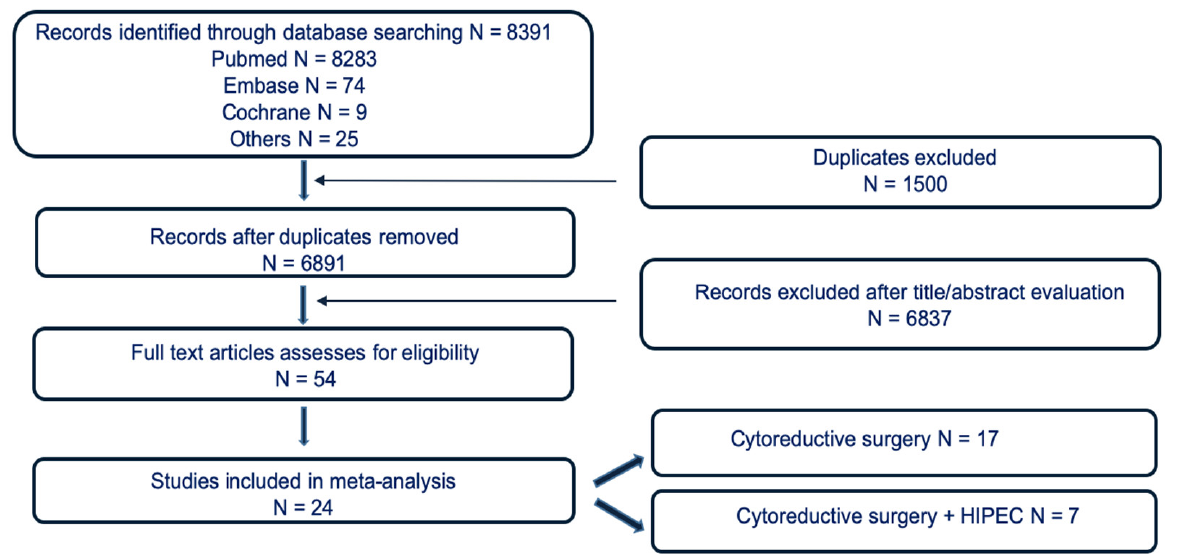
Figure 1. Study Flow Chart.